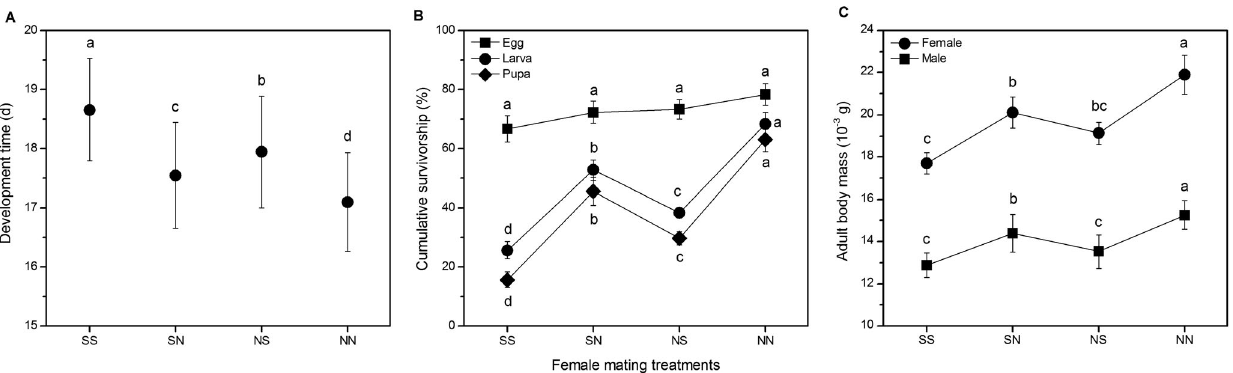
Figure 3. Variation in offspring life history traits among treatment groups. Effect of treatment groups on (A) egg-to-adult developmental time, (B) cumulative survival and (C) adult body mass for offspring from doubly mated C. bowringi females under four treatments. Black dots and error bars represent mean and standard error. Different letters indicate significant differences based on ANOVA with Tukey’s HSD post hoc analyses ( P ,